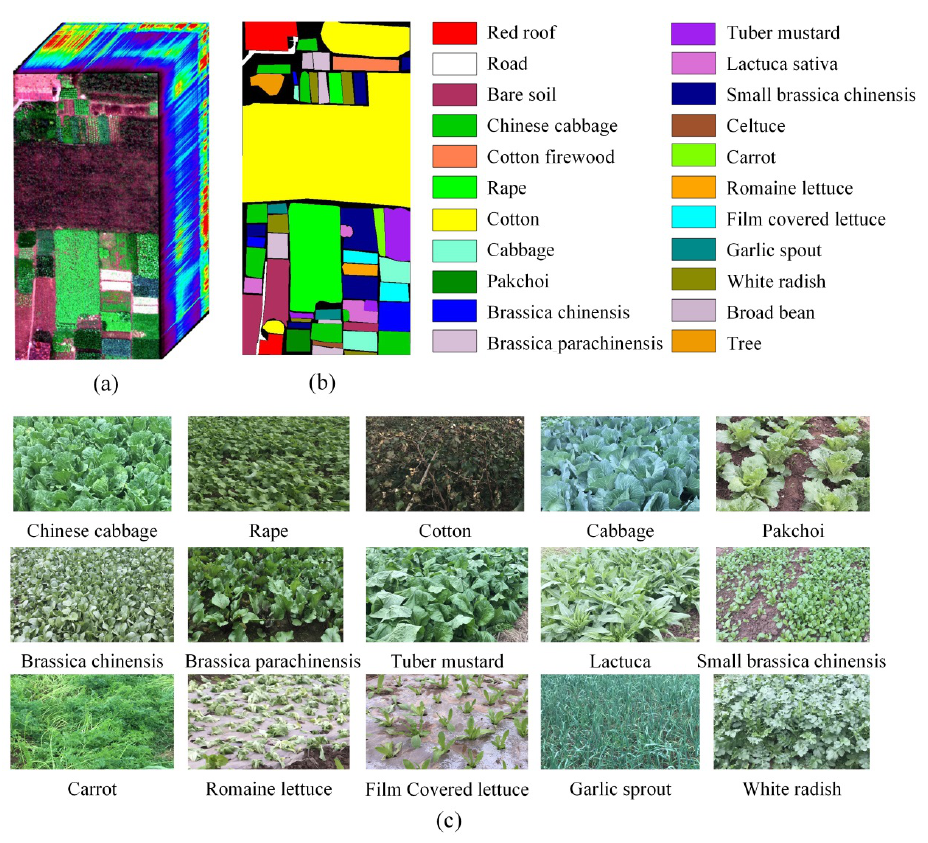
Figure 4. The HongHu dataset: ( a ) Hyperspectral image; ( b ) Ground truth; ( c ) Typical crop photos in the study area. Table 9. OAs (%) and Kappa coefficients obtained by different methods for the Honghu dataset using RF with different numbers of training samples per class.